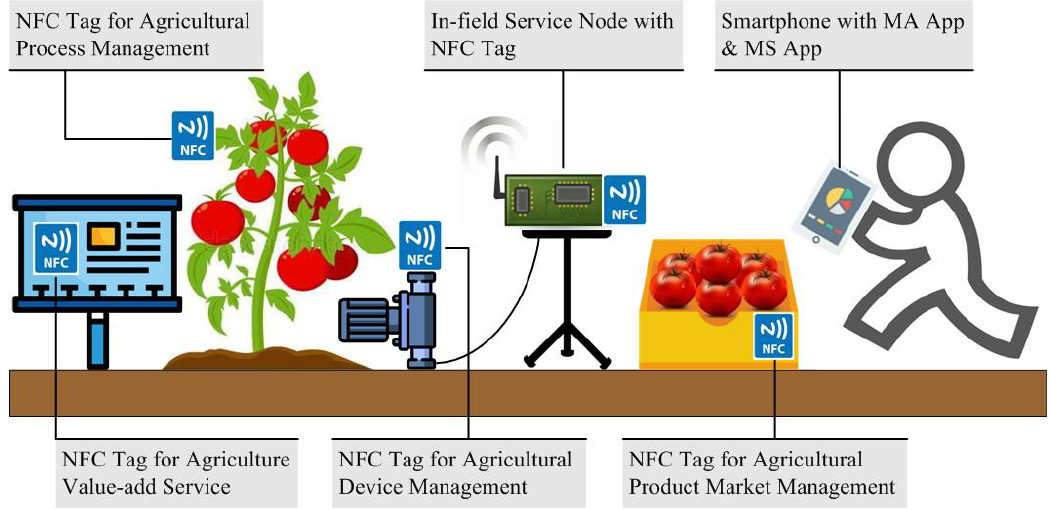
Figure 3. NFC tags and related functions in tomato greenhouse.